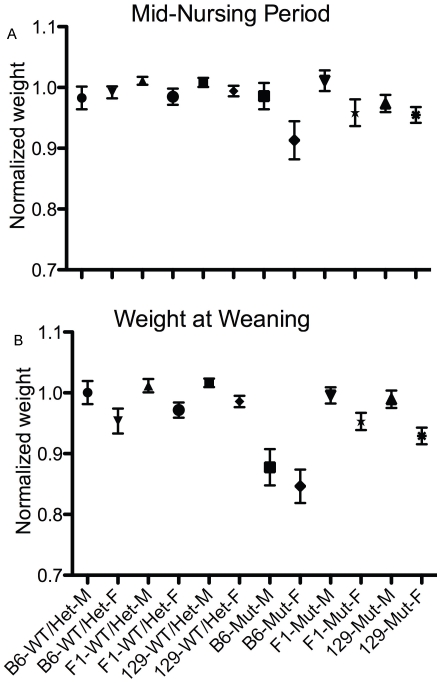
ATP8B1 mutant B6 mice exhibit slower weight gain during the nursing period.Pup weight in WT and ATP8B1 mutant mice of B6, 129, and F1 backgrounds at: A) mid-nursing period (∼day 10) and B) weaning. Weights of mutant pups were normalized to those of WT and heterozygote littermates; means and SEM are shown. Range of N's: a) B6 (n = 14−56), 129 (n = 23−57), and F1 (n = 70−136) and b) B6 (n = 12−53), 129 (n = 23−58), and F1 (n = 50−138).